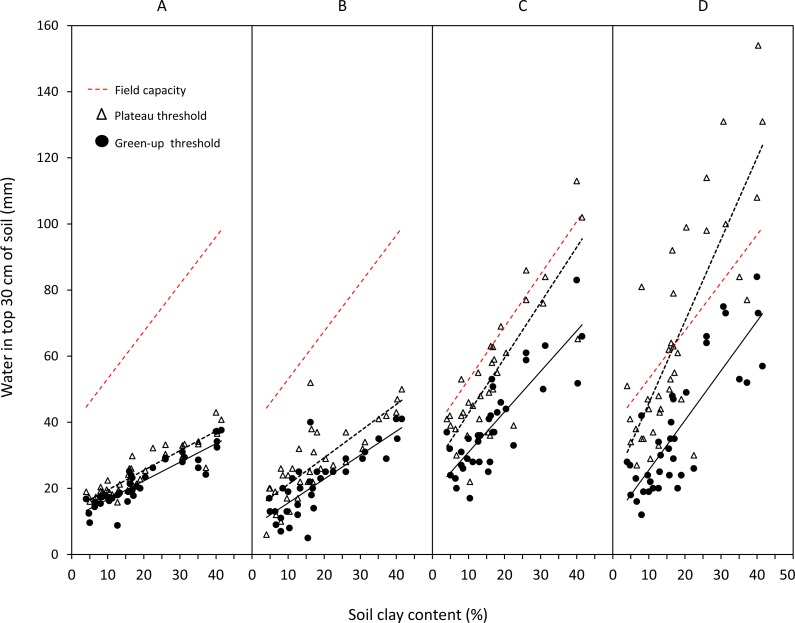
Linear regressions between clay content and field capacity of the 30 cm soil profile and green-up (M1) and plateau (M2) soil water thresholds for each food type.Green leaves (A); mixed grass (B); green grass (C); green forbs (D). Equations, adjusted R2 and P values for regressions: green leaves, M1 = 11.022 + 0.563X(R2 = 0.81, P < 0.001), M2 = 12.645 + 0.663X(R2 = 0.87, P < 0.001); mixed grass, M1 = 8.346 + 0.724X(R2 = 0.64, P < 0.001), M2 = 13.423 + 0.774X(R2 = 0.54, P < 0.001); green grass, M1 = 18.671 + 1.225X(R2 = 0.69, P < 0.001), M2 = 26.22 + 1.673(R2 = 0.70, P < 0.001); green forbs, M1 = 10.52 + 1.502X(R2 = 0.68, P < 0.001), M2 = 18.493 + 2.63X(R2 = 0.68, P < 0.001).